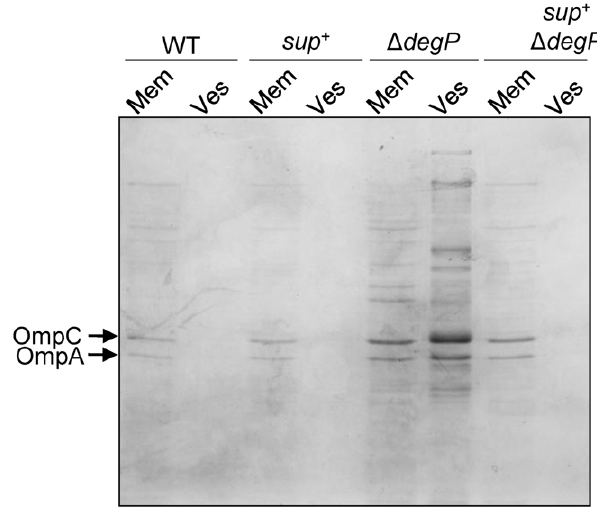
Figure 3. The suppressor mutation reverses the vesiculation phenotype of a D degP strain. Cultures were grown at 39 u C in Luria broth for five hours, after which membranes and vesicles were prepared as described in the Experimental Procedure section. Samples were analyzed by SDS-PAGE and proteins were visualized after Coomassie blue staining. Abbreviations: mem, membrane; ves, vesicle; sup + , the unknown suppressor mutation.